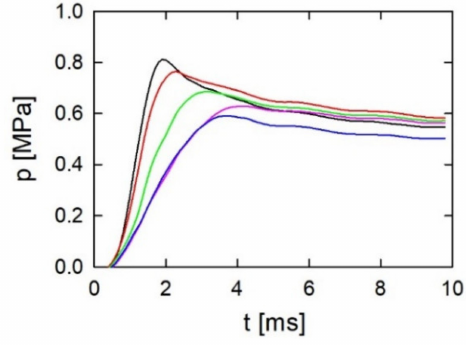
Figure 9. Pressure courses were recorded for the chamber filled with 2 mm glass